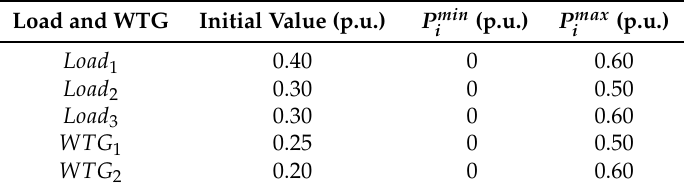
Table 2. Simulation parameters of load demand and wind turbine generator (WTG).